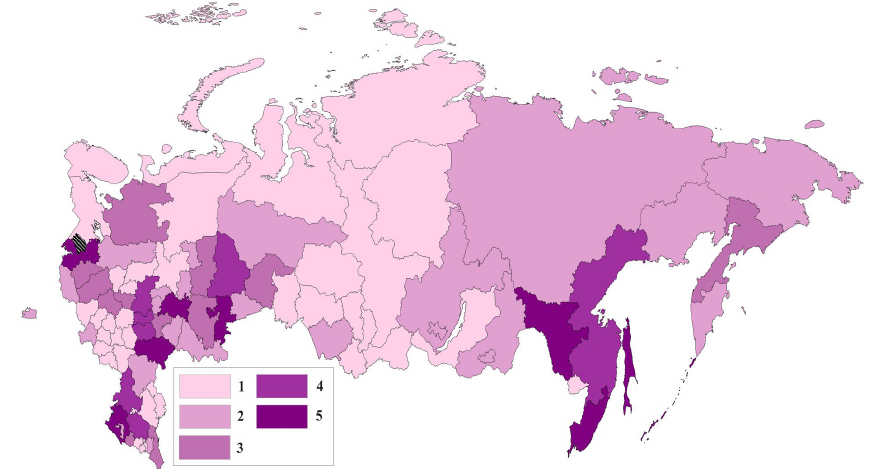
Fig. 4. Frequency of “blackouts” triggered by natural hazards (average annual number of events): 1 – less than 0.1; 2 – 0.1–0.3; 3 – 0.4–0.6; 4 – 0.7–0.9; 5 – 1 and more. Table 2. Criteria for hazardous weather events in Russia (according to the Hydrometeorological Centre of Russia). Criteria Events by intensity by